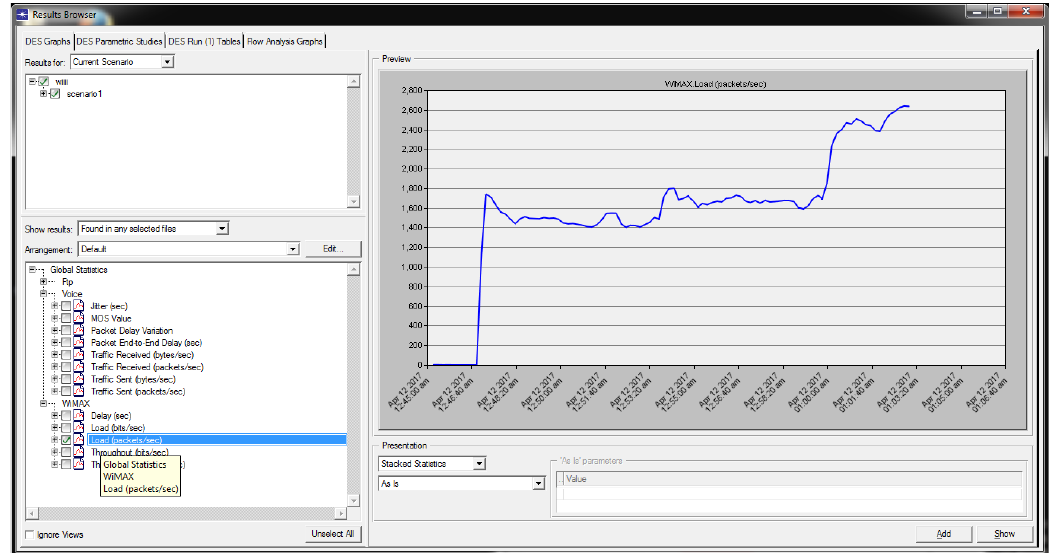
Fig. 4. Global Statistics WiMax Load Packet/second for overall network, reaches 2450 (2.450kbps) bit per second approximately.